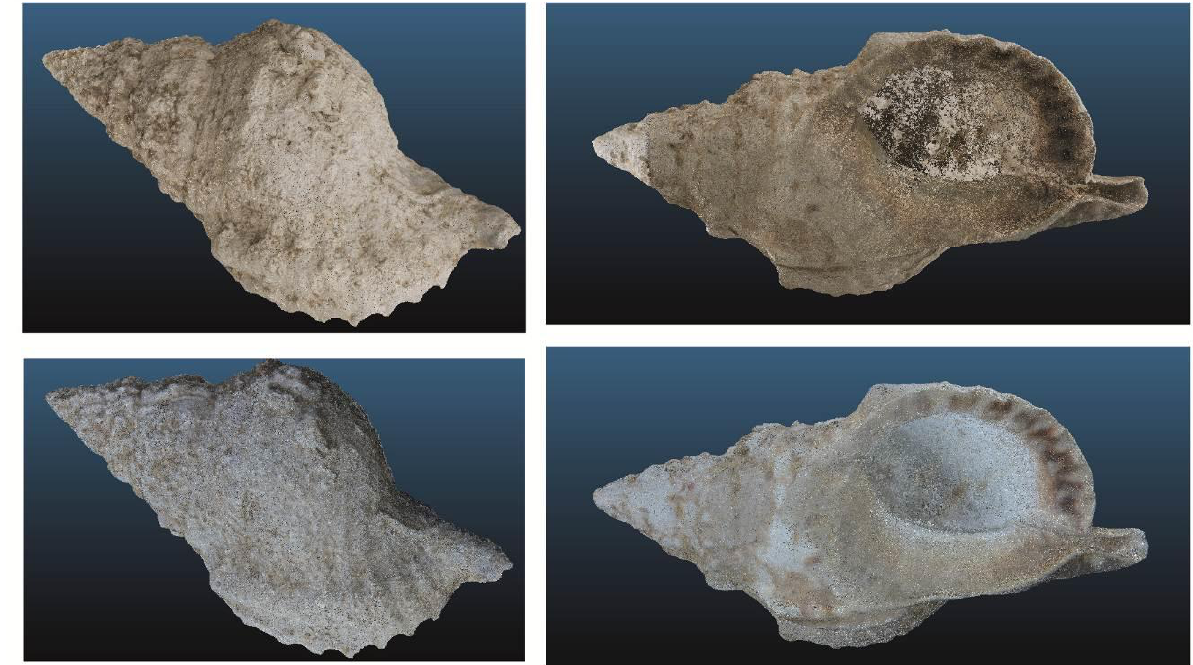
Figure 6. On the top the “dry” 3D point cloud, while in the bottom the same corresponding views of the underwater